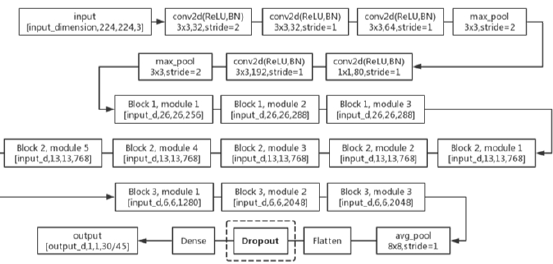
Figure 4. Improved Inception-V3 Network Architecture